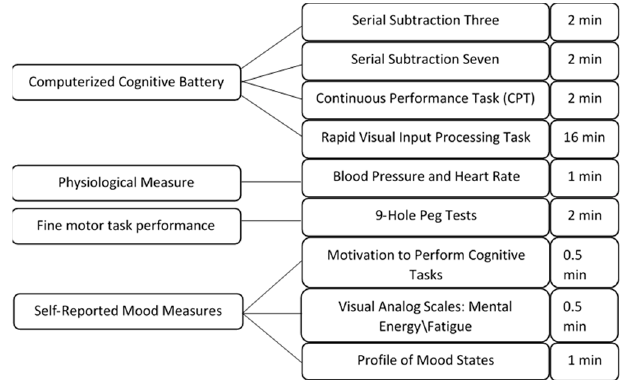
Figure 1. Test battery sequence.